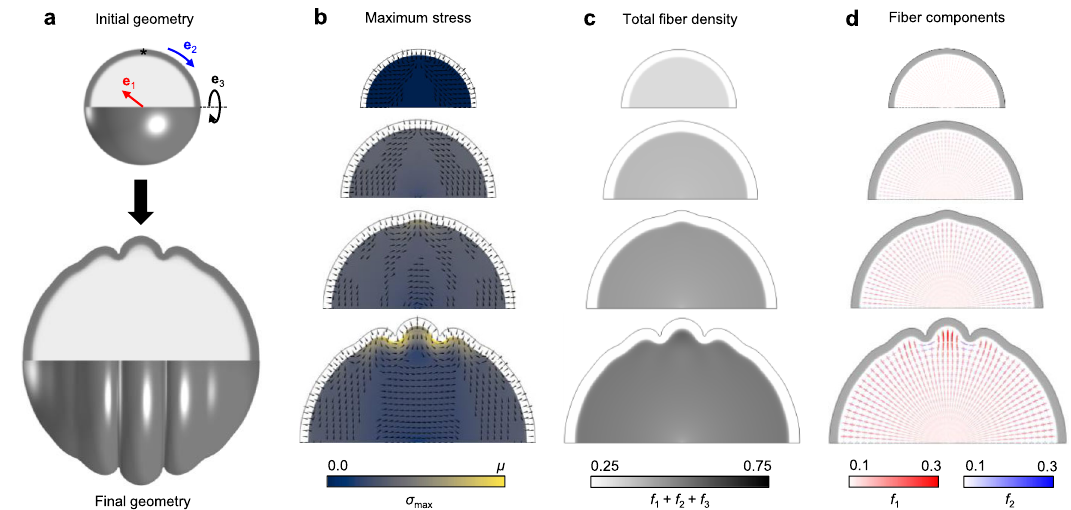
Fig. 2 Cortical folding induces stereotyped fi ber organization beneath gyri and sulci. a Model geometry before and after folding. For the axisymmetric model, material coordinate directions are de fi ned in radial ( e 1 ), circumferential-tangential ( e 2 ), and axisymmetric-tangential directions ( e 3 ), and can be followed over the course of deformation. The asterisk denotes the location of a symmetry-breaking perturbation. b – d Evolution of maximum stress ( b ), total fi ber density ( c ), and directional fi ber components ( d ) in the subplate over the course of folding. From top to bottom, simulation time T = 0, 0.5, 0.75, 1. In b , colormap indicates the magnitude of maximum Cauchy stress ( σ max ) at each point in the subcortical layer, ranging from 0 to μ = 300 Pa (shear modulus of tissue, as de fi ned in Methods). Tick marks indicate the maximum stress direction, with no visible tick marks indicating the e 3 direction. In c , greyscale indicates the magnitude of total fi ber density, where f 1 , f 2 , f 3 , indicate the fi ber volume fraction in directions e 1 , e 2 , e 3 , respectively. In d , crosses ( + ) are used to visualize local fi ber volume fraction in terms of radial and (circumferential) tangential directions. Magnitude of fi ber volume fraction in these speci fi c directions is represented by color (radial fi bers in red, tangential fi bers in blue), such that a dark red region indicates increased radial fi bers per unit volume, dark blue indicates increased tangential fi bers per unit volume, and light color indicates relatively low fi ber volume